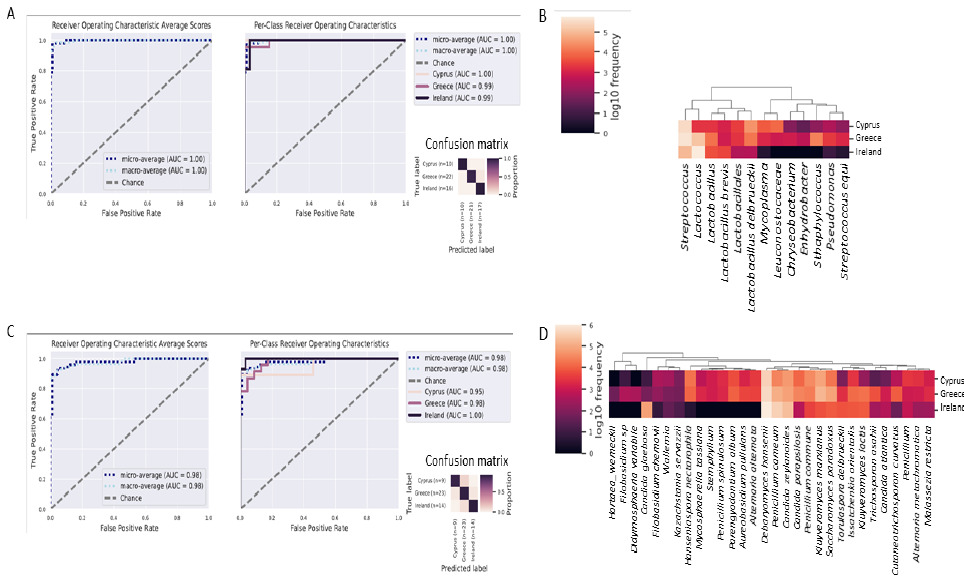
Figure 7. Microbial taxa that can accurately differentiate cheeses from Ireland, Greek and Cyprus. ( A ) ROS and PCROC analyses for bacterial taxa, indicating true and false positive rates for cheeses from each country, shows perfect predictive accuracy (AUC = 1.00). The confusion matrix shows the proportion of how many times every sample gets the correct classification. ( B ) Heatmap showing the 13 top bacterial predictive features that differentiate cheeses from each country. ( C ) ROS and PCROC analyses for fungal taxa, indicating true and false positive rates for cheeses from each country, shows perfect predictive accuracy (AUC = 1.00). The confusion matrix shows the proportion of how many times every sample gets the correct classification. ( D ) Heatmap showing the 30 top fungal predictive features that differentiate cheeses from each country.